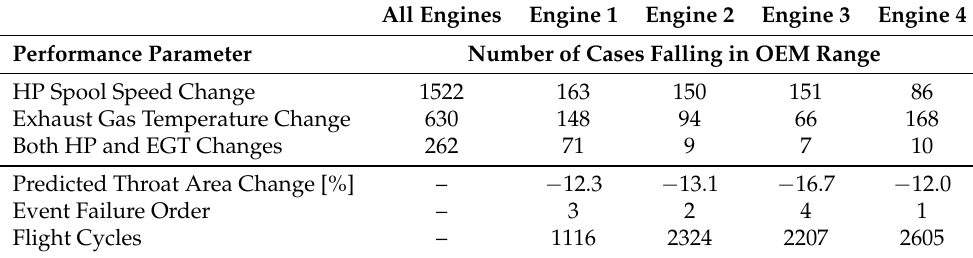
Table 3. A summary of the number of Monte Carlo cases (of 4000) that satisfy the recorded perfor- mance changes for each engine in the Galunggung event. Additionally indicated are the predicted NGV throat area reductions corresponding to these cases that reflect the order of engine failures during the